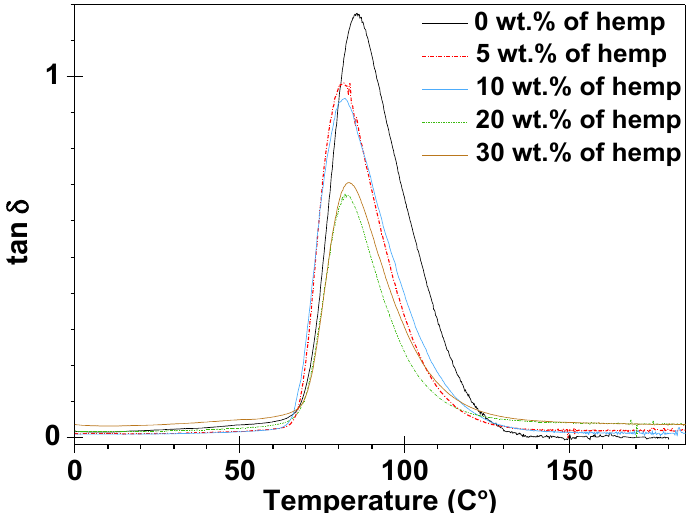
Figure 8. Storage modulus versus temperature for all compositions.